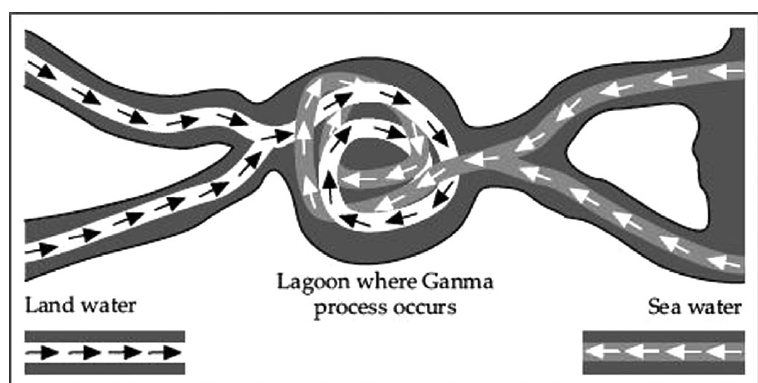
Representation of Ganma (Marika, 1999, pp.